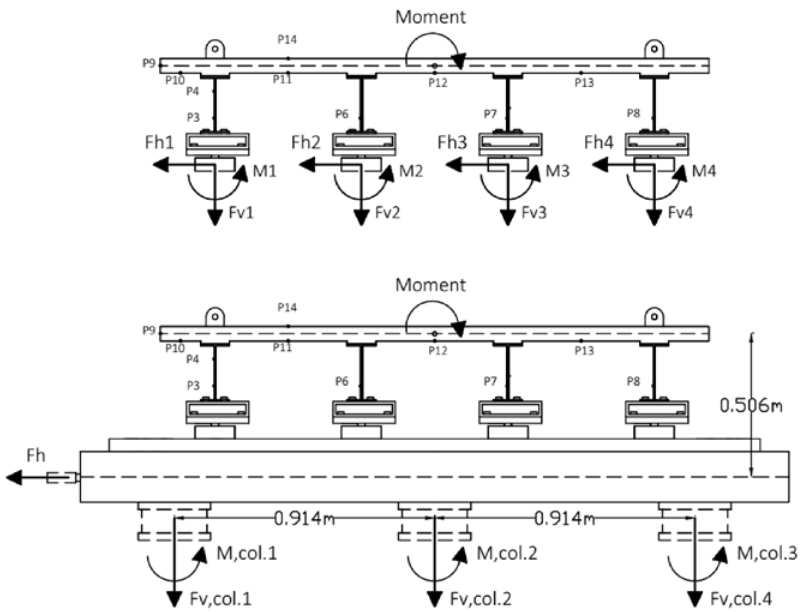
Figure 12. Calculation of tsunami-induced moment at the level of the bearings (top) and the level of the column-bent cap connections (bottom).